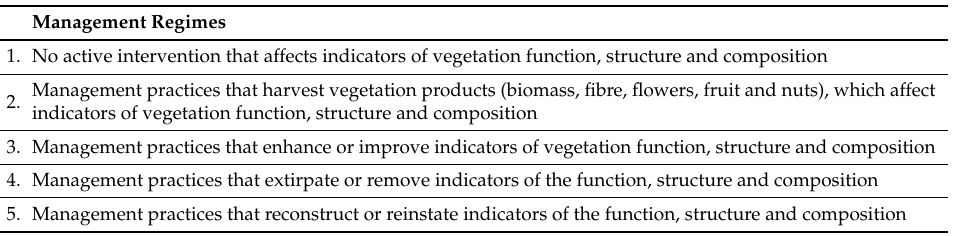
Table 2. Five land management regimes used to evaluate the response of a native plant community to land management practices, relative to the reference